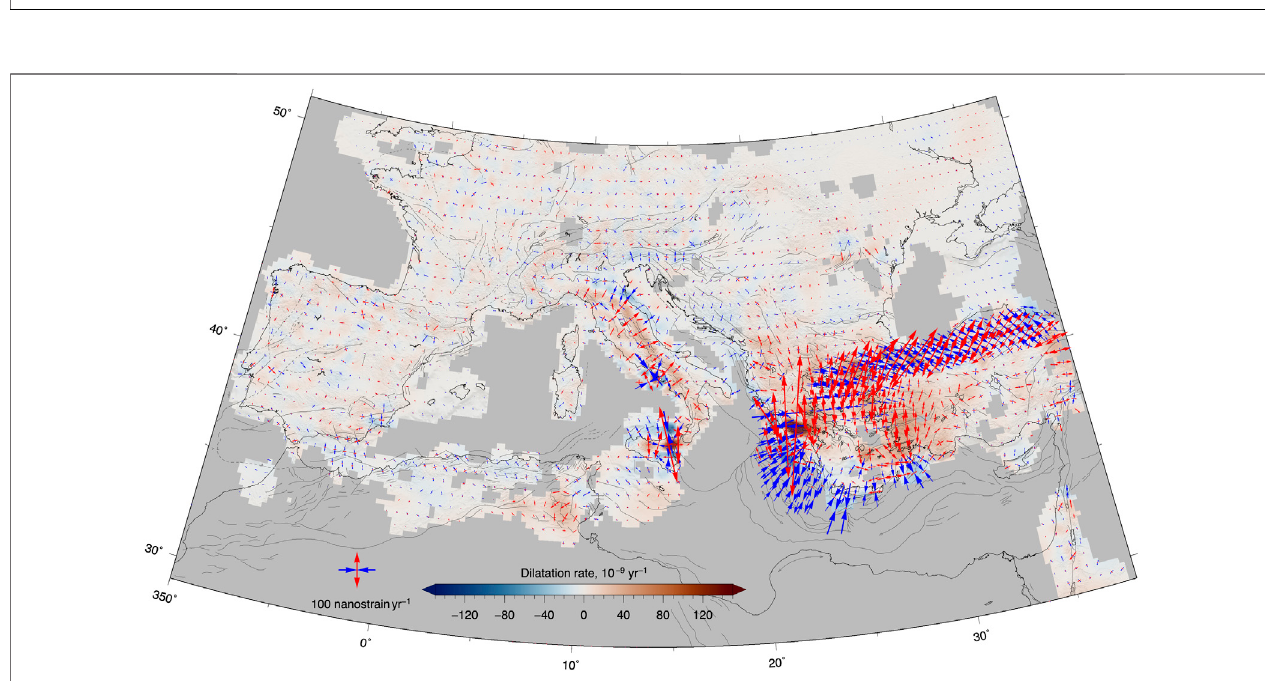
FIGURE 10 | Map of the dilatational rate, where blue and red colors indicate contractional and extensional deformation, respectively. The diverging (blue) and converging (red) arrows show the axes of the principal strain-rates.